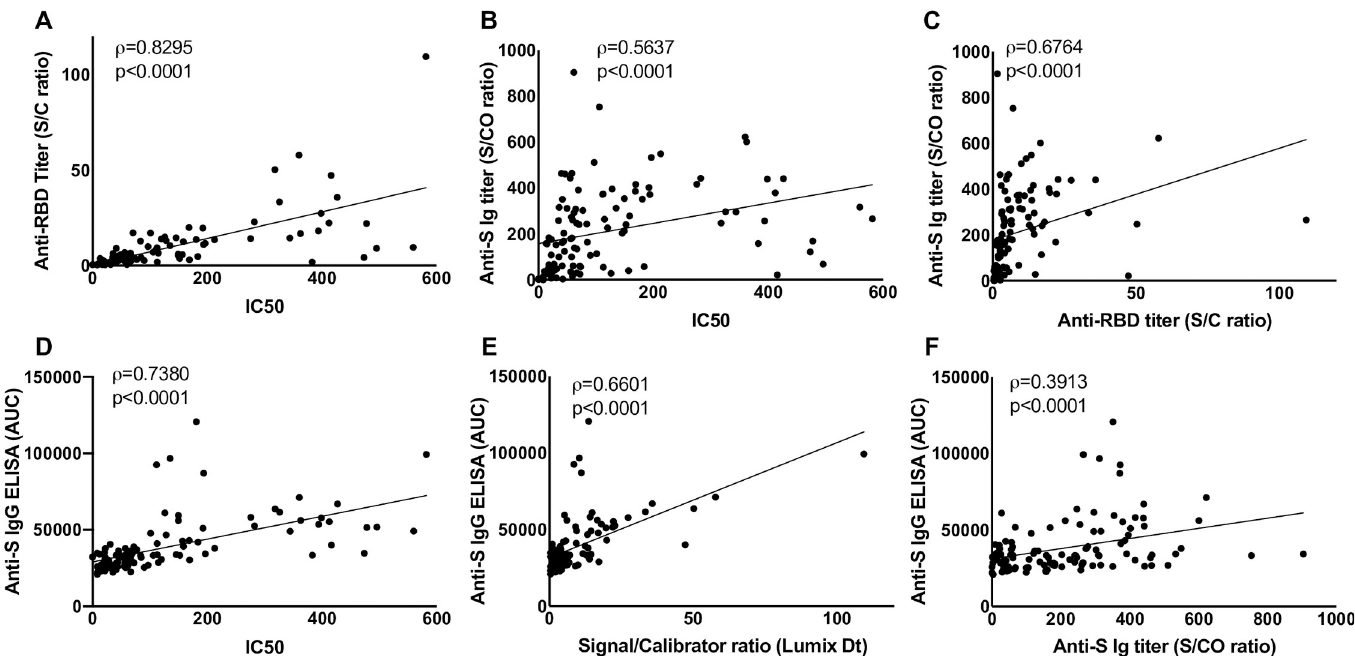
Fig 1. Correlative analysis of anti-SARS-CoV-2 immunoassays. Assays were performed to detect anti spike- Immunoglobulin (Ig) using the Ortho-Vitros assay (represented by signal to cut-off ratios (S/CO)), or anti-spike IgG with ELISA (represented by area under the curve, AUC), anti-RBD Ig using the Lumit Dx assay (represented by sample signal to calibrator ratios (S/C)) and 50% neutralizing titers with a retroviral-pseudotype assay (represented by IC50). Analysis of correlation were performed using Spearman’s correlation test for (A) anti-RBD titer, S/C vs IC50, (B) total anti-S Ig titer, S/CO vs IC50 and(C) anti-RBD titer, S/C vs total anti-S Ig titer, S/ CO. These assay results were also qualified by comparing IC50 (D), anti-RBD titer, S/C (E) and total anti-S Ig titer, S/CO (F) against an in-house anti-spike protein IgG ELISA. Spearman’s correlation coefficient, ρ , and p values are indicated for each correlation.